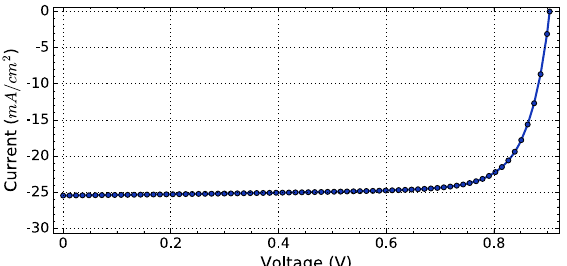
Fig. 7. External and internal quantum ef fi ciency spectra of the InGaN PN solar cell at